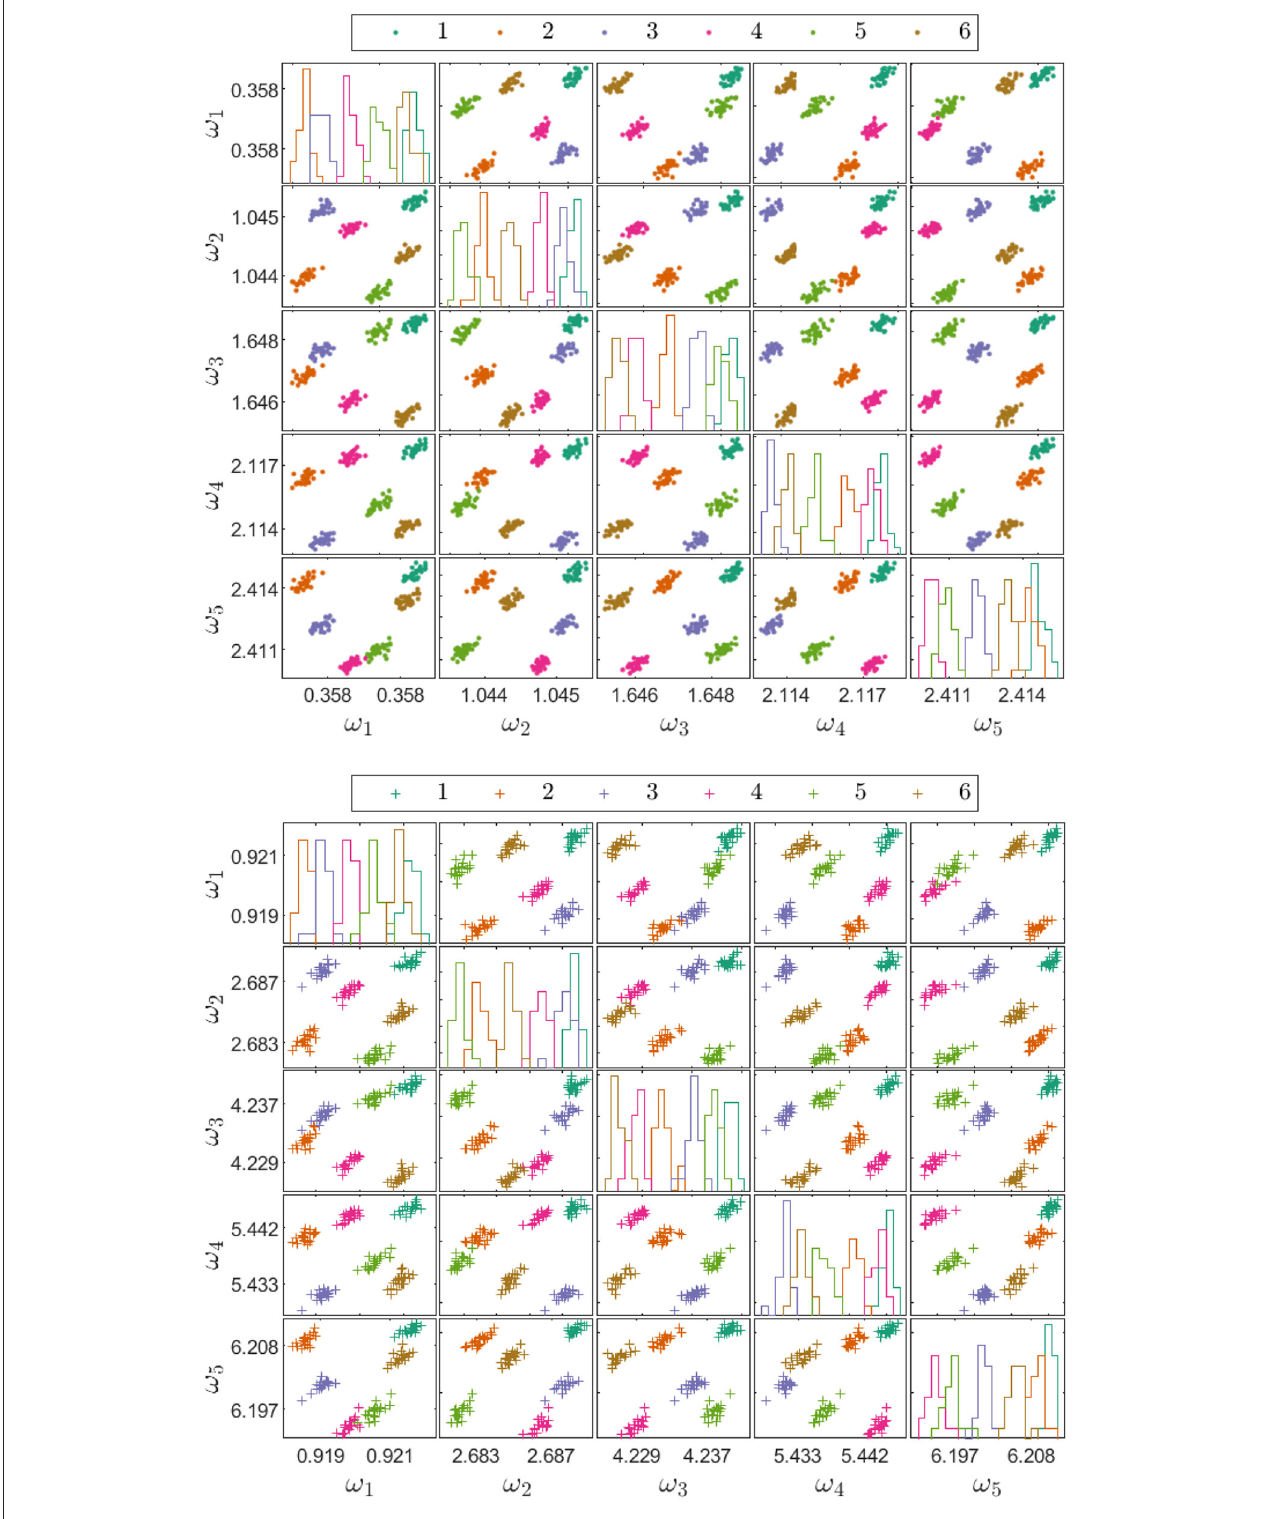
FIGURE 6 | Source and Target domain features for the heterogeneous population case study with geometric and material differences (where damped natural frequencies are in Hz).